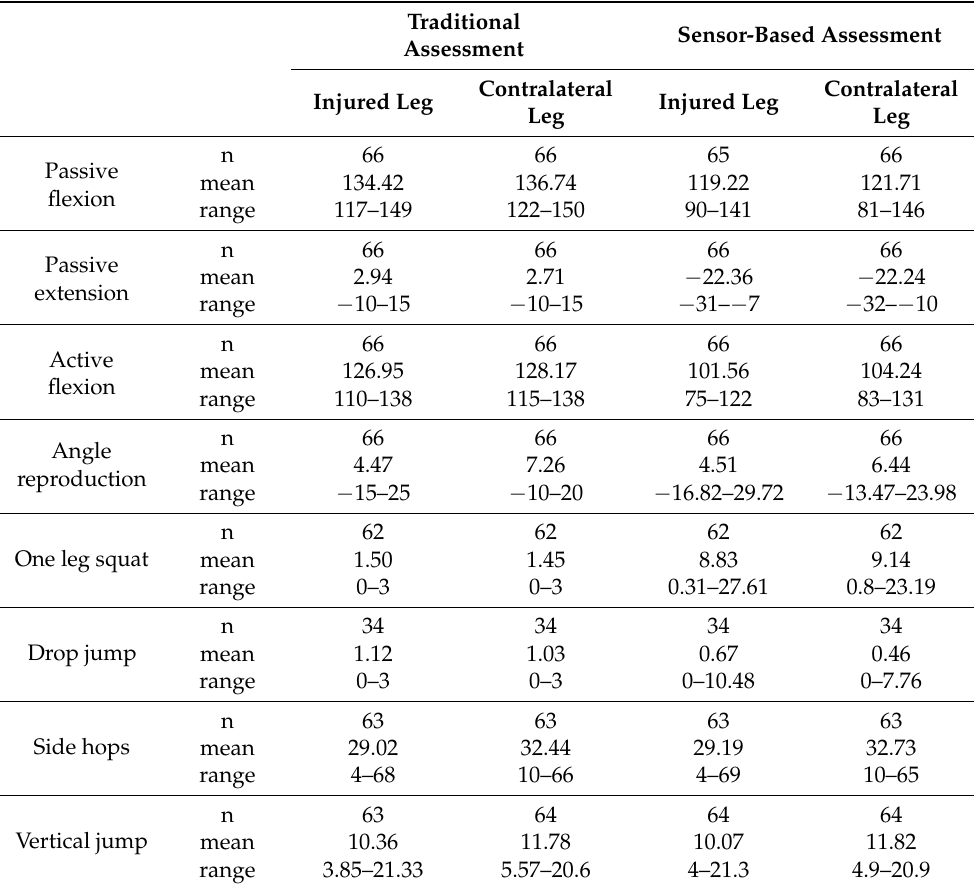
Table 4. Characteristics of the measured parameters.